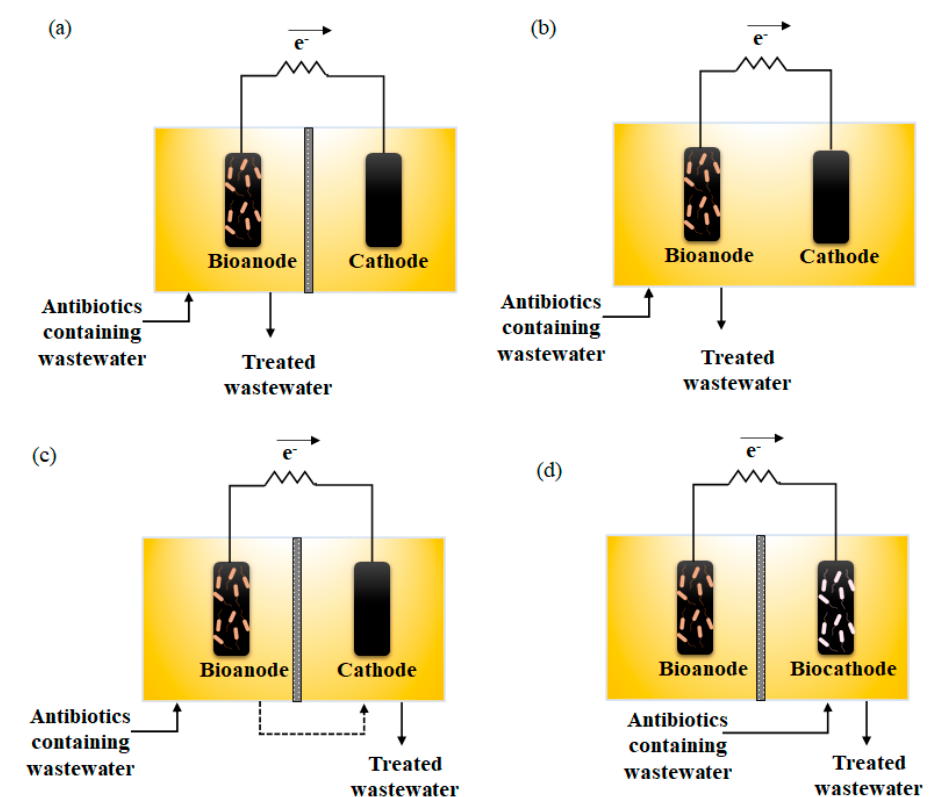
Figure 1. Different process schemes studied for antibiotics removal in MFCs: ( a ) dual-chamber MFC, ( b ) single-chamber MFC, ( c ) sequential anode-cathode operation in a dual-chamber MFC, and ( d ) biocathode operation in a dual-chamber MFC.